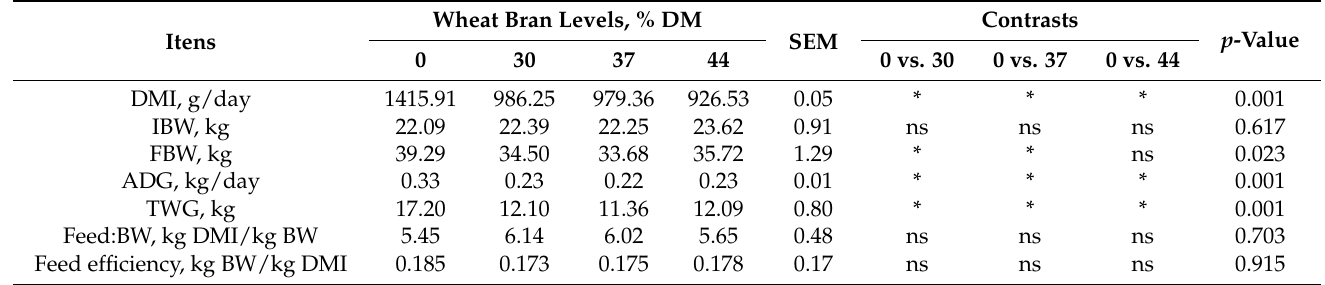
Table 6. Carcass characteristics of lambs fed diets with cactus pear as the only forage source and levels of wheat bran. Wheat Bran Levels, % DM Traits